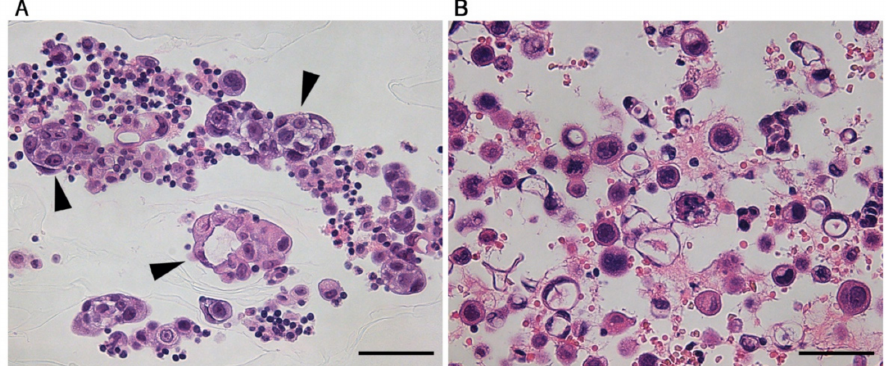
Figure 3. Morphological characterization of malignant pleural effusion (MPE). ( A ) A representative hematoxylin and eosin (HE)-stained image of an MPE with many clusters. Arrowheads indicate clusters. A cluster was defined as a cell assembly consisting of at least five cancer cells. ( B ) A representative HE image of an MPE consisting of almost entirely isolated cells. The bars indicate 50 µ